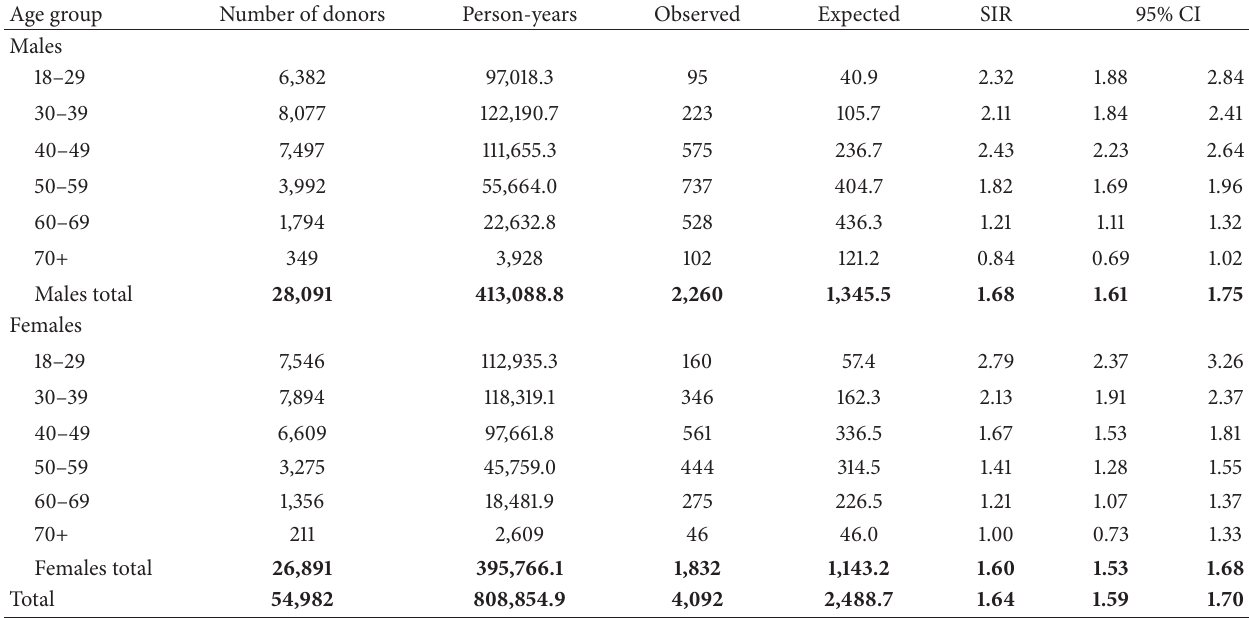
Table 2: Standardized incidence ratio (SIR) for all cancers, allogeneic blood donors with more than one year of followup, Blood Centers of the Pacific, 1991–2009 ( 𝑛 =